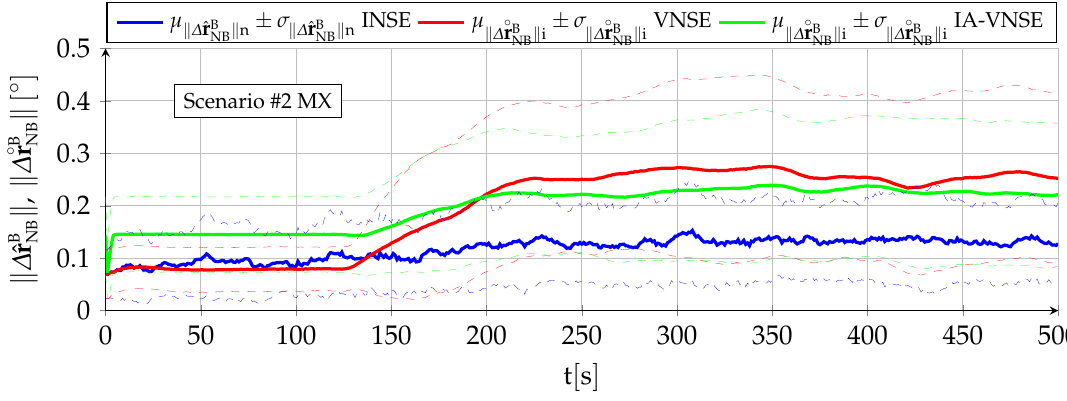
Figure 9. Body attitude INSE, VNSE, and IA-VNSE for scenario #2 MX (100 runs).